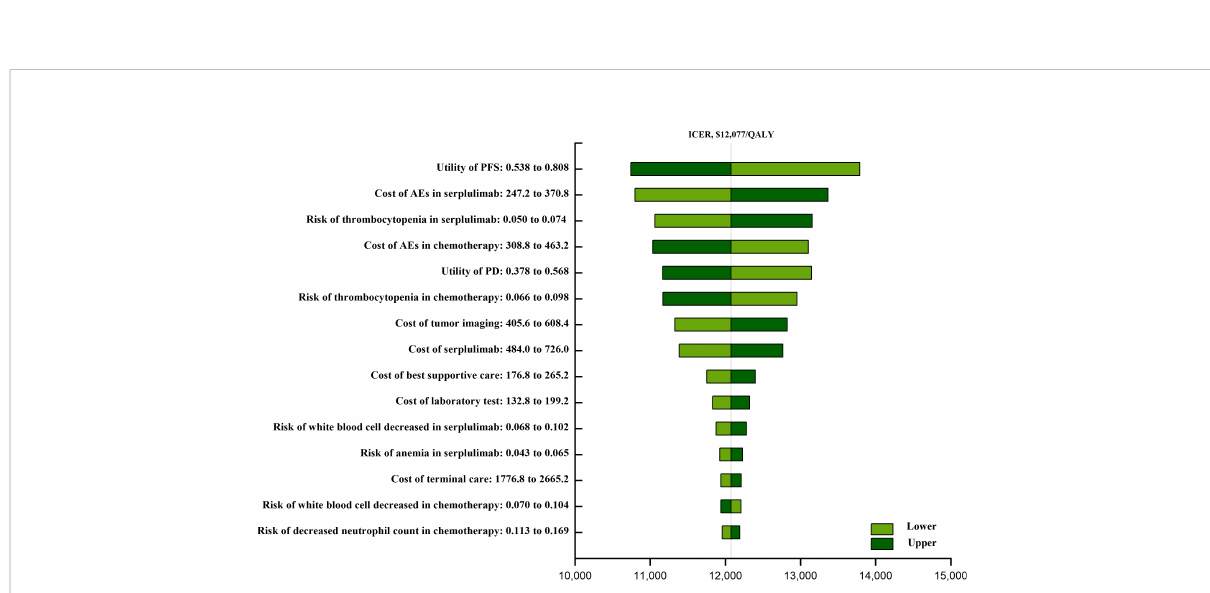
FIGURE 1 The one-way sensitivity analyses of serplulimab plus chemotherapy group and chemotherapy group. PFS, progression-free survival; AEs, adverses events; PD, progressive disease.